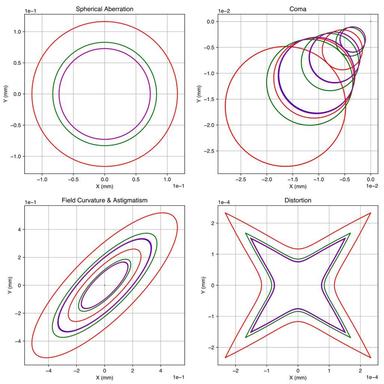
Individual aberration spot diagram, obtained via the DA method for four different voltage ratios. Spherical aberration parameters: Object plane semi-angle: 10mrad. Coma parameters: Object plane semi-angle: 10mrad. Object plane radial position: 0to0.1mm. Field curvature & astigmatism parameters: Object plane semiangle: 10mrad. Object plane radial position: 1mm. Distortion parameters: Object plane position: Square of side length 0.2mm centred about 0.